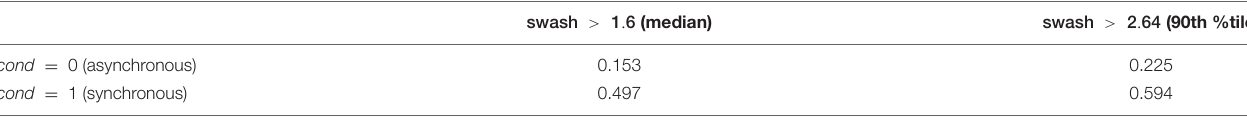
TABLE 6 | Summaries of the posterior distributions of the model with the linear predictor (Eq. 7) showing the means, standard deviations, and 95% credible intervals. Parameter Coefficient of Mean SD β 0